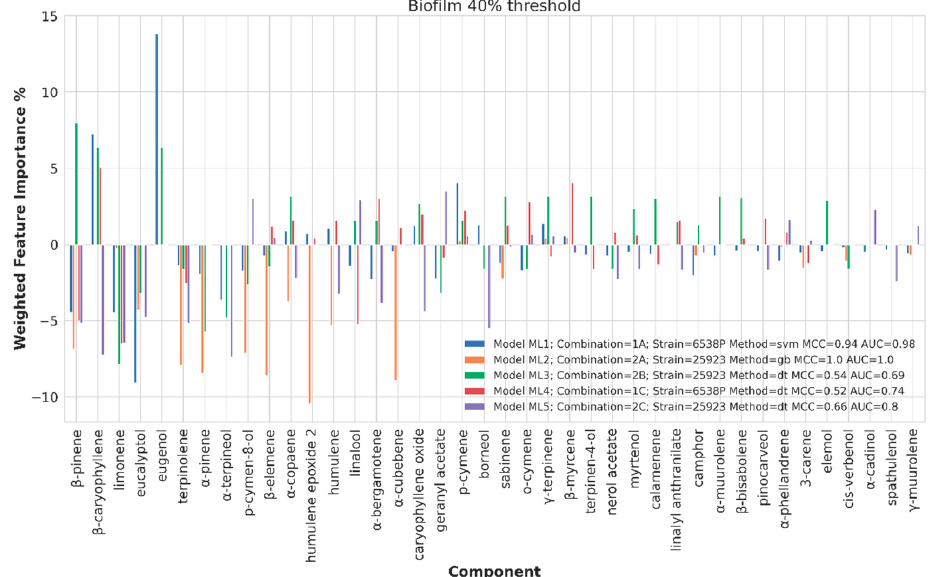
Figure 6. Weighted feature importance (WFI) plot for models obtained on the dataset binarized at 40% biofilm inhibition. Positive bars are associate with inhibition of biofilm production, whereas negative bars are associated with augmented biofilm production.